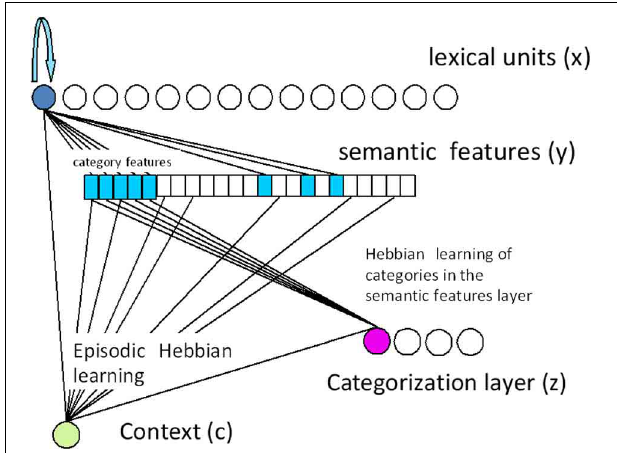
FIGURE 4 | Schematic diagram of the encoding stage of the model. The top layer is the lexical layer, the middle is the semantic features layer. Context is represented by a single unit (list context) in the bottom-left, and the categorization layer (component of the PFC) is illustrated in the bottom-right. During list presentation, lexical units receive input. Activation spreads to the semantic features layer and further to the categorization layer. Episodic encoding by Hebbian learning takes place between the context and the lexical, semantic and categorization layers. In addition, fast Hebbian learning takes place between the categorization layer and the semantic